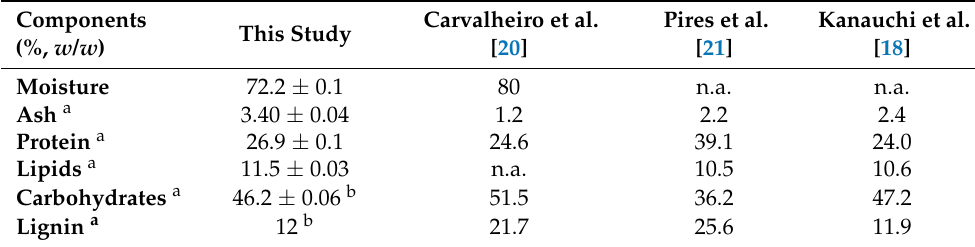
Table 1. Chemical composition of the BSG used in this study and comparison with literature data.